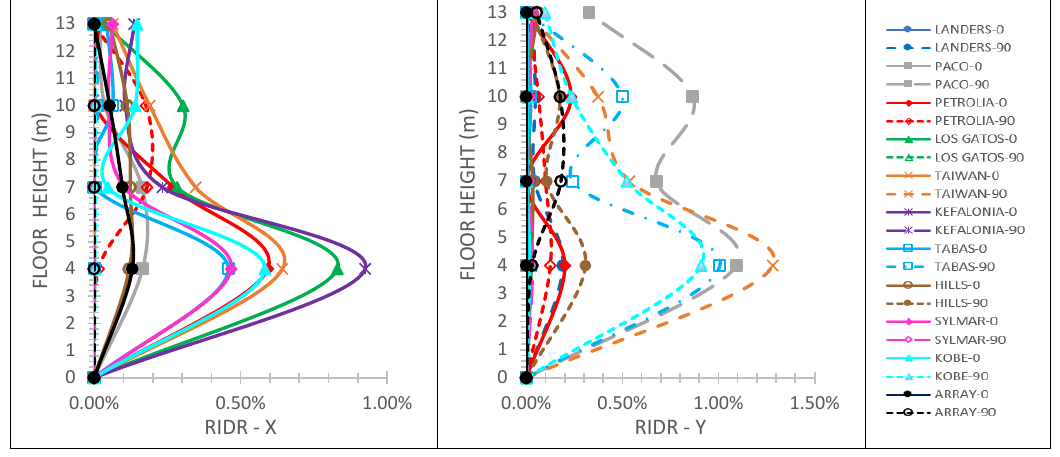
Figure 11. RIDR along X ( left ) and Y ( right ) horizontal directions of the four-story mixed building, considering the fixed connection of the steel structure to the r/c one.